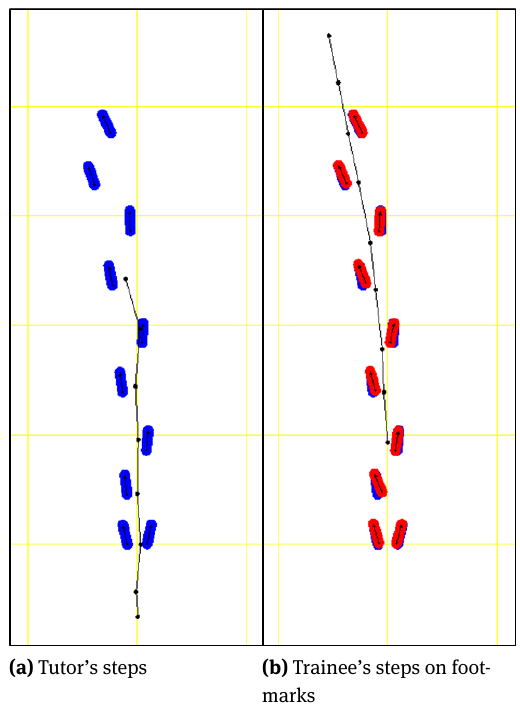
Fig. 22. Result of Straight-line Trajectory